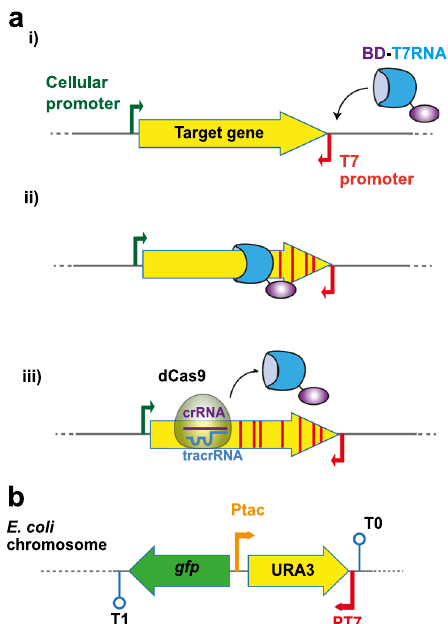
Fig. 1 Graphic summary of the mutagenesis system development. a Schematic representation of the mutagenic process. The T7 RNA polymerase fusion (BD-T7RNAP, blue shape joined by a black line to a purple elliptical shape) speci fi cally binds the T7 promoter (i), initiating the transcription and moving along the target gene (yellow fi lled arrow) carrying the base deaminase (BD) that introduces mutations (red stripes) in the gene (ii). The fusion stops and detaches from the DNA when encounters a dCas9 molecule (translucid ovoid shape) bound to a speci fi c sequence determined by the CRISPR RNA (crRNA, purple line). The trans - activating CRISPR RNA (tracrRNA, blue line) is also required for this process (iii). b Representation of the chromosomally integrated reporter gfp - URA3 cassette to test the mutagenesis system. The genes gfp and URA3 are represented with green and yellow fi lled arrows, respectively. Thin arrows indicate the promoters tac (P tac ) and T7 (P T7 ), lollipops indicate terminators T0 and